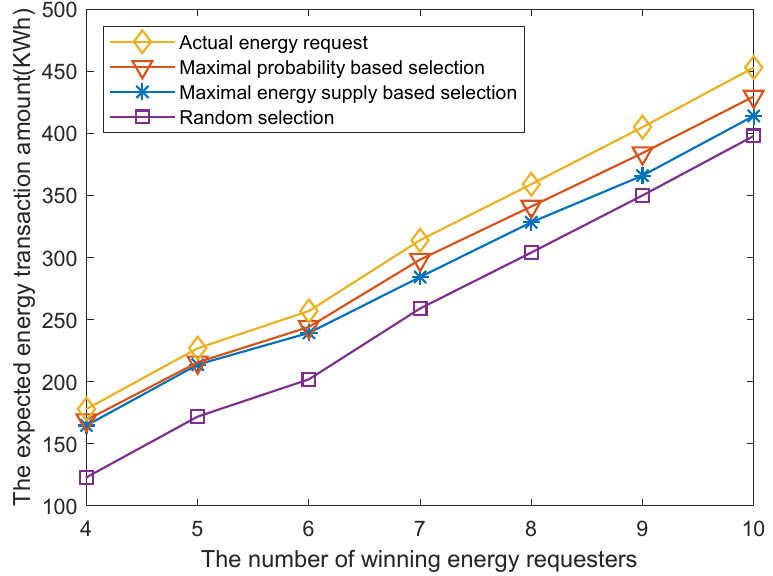
Figure 4. The total energy transaction amount when the number of energy requesters varies.